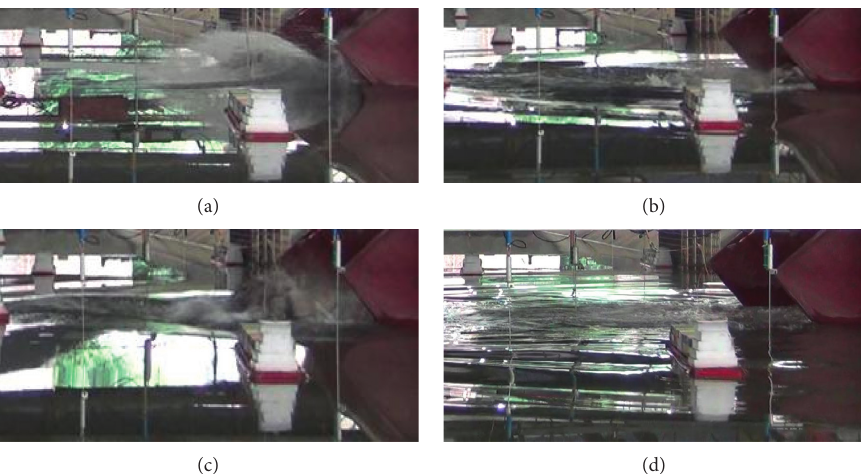
Figure 8: The process of impulse waves formation. (a) The first wave crest. (b) The first wave trough. (c) The following wave crest and trough. (d) Trailing wave